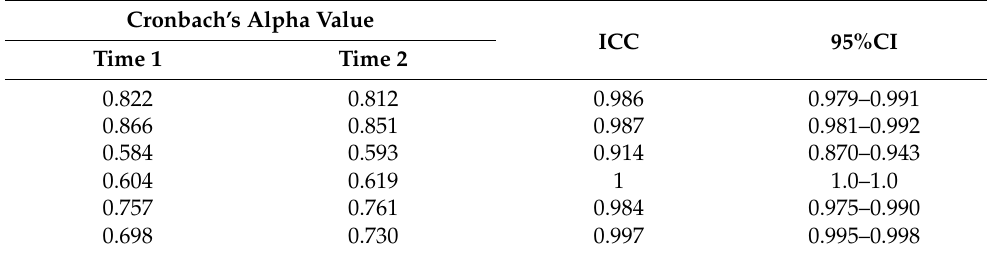
Table 2. Reliability—Internal Consistency and Intraclass Correlation of SIT-Q-7d-Chi (N = 84).